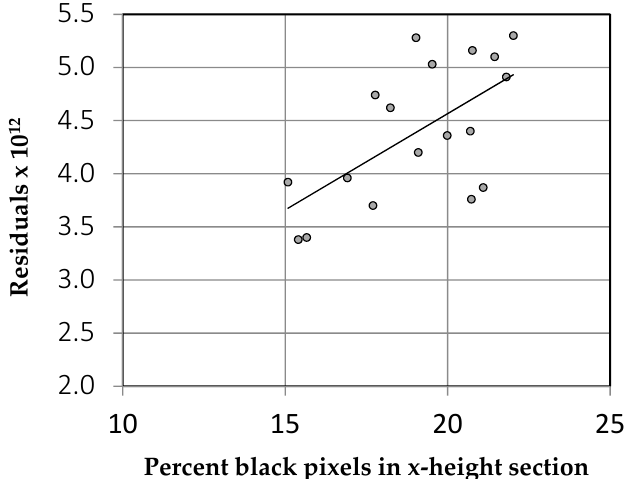
Figure 9. The correlation between font weight and the output of the algorithm (residuals) [25].